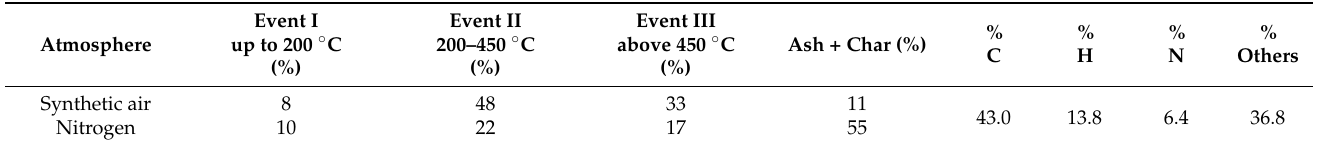
Figure 1. Thermogravimetric analysis of Desmodesmus sp. microalgae biomass under nitrogen gas flow (TG: red curve, DTG: blue curve, DTA: black curve). Table 1. Percentage of mass loss for events (I) (water), (II + III), volatiles under N 2 flow and ash + char, C, H and N contents of Desmodesmus sp. biomass.